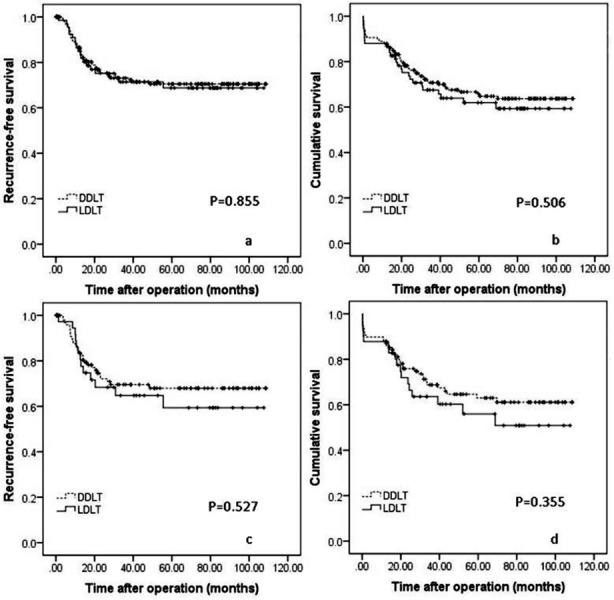
RFS (Fig.4a) and OS (Fig.4b) for patients outside of Milan criteria following LDLT versus DDLT. RFS (Fig.4c) and OS (Fig.4d) curves for patients in the Milan, UCSF, up-to-seven, Hangzhou and Chengdu criteria following liver transplantation.